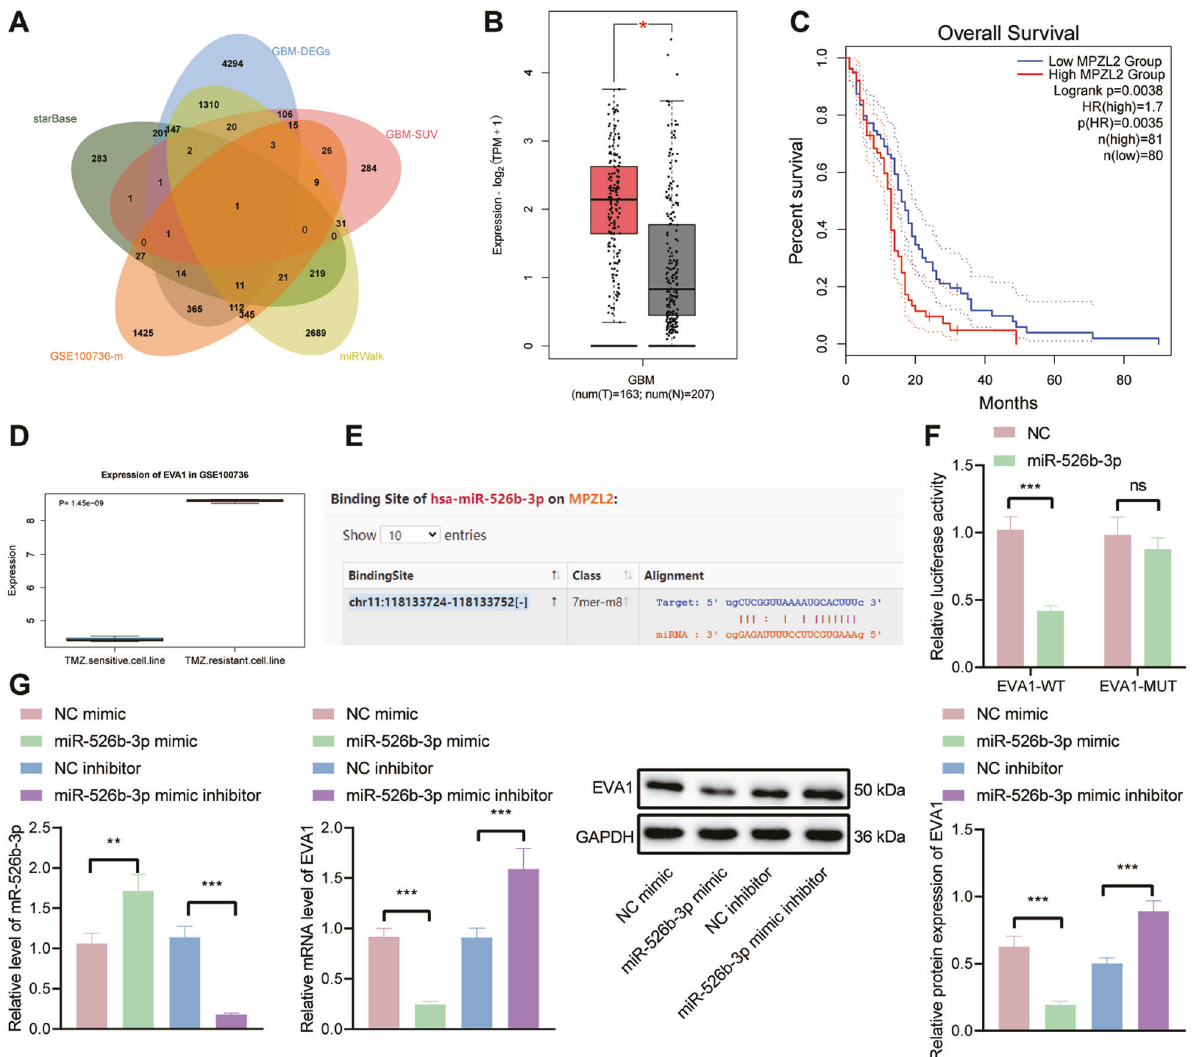
expression in TCGA-GBM. The red box on the left indicates GBM samples, and the gray box on the right indicates normal samples. C Correlation analysis of EVA1 expression with the overall survival of GBM patients in TCGA-GBM. D EVA1 expression in the TMZ resistance- related GSE100736 data set. E The predicted binding sites between miR-526b-3p and EVA1 by the starBase database. F Binding of miR-526b- 3p to EVA1 con fi rmed by dual-luciferase reporter assay. G RT-qPCR and western blot analysis detection of EVA1 expression in U251 cells transfected with miR-526b-3p mimic or miR-526b-3p inhibitor. * p < 0.05, ** p < 0.01, or *** p < 0.001. ns indicates no signi fi cant difference between the two groups. Each experiment was repeated three times